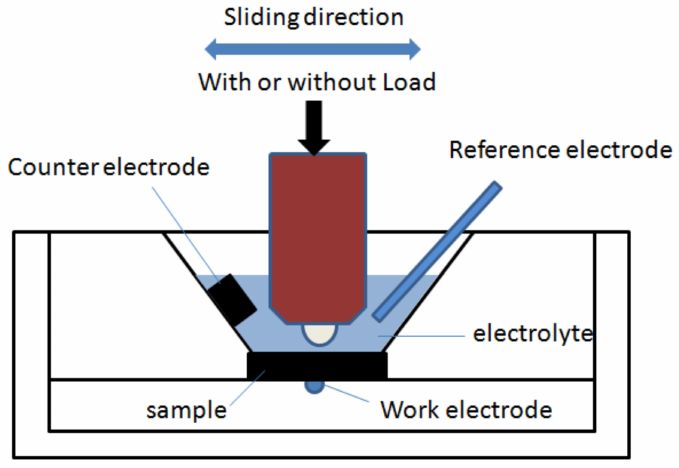
Figure 1. The scheme of the corrosion and tribocorrosion